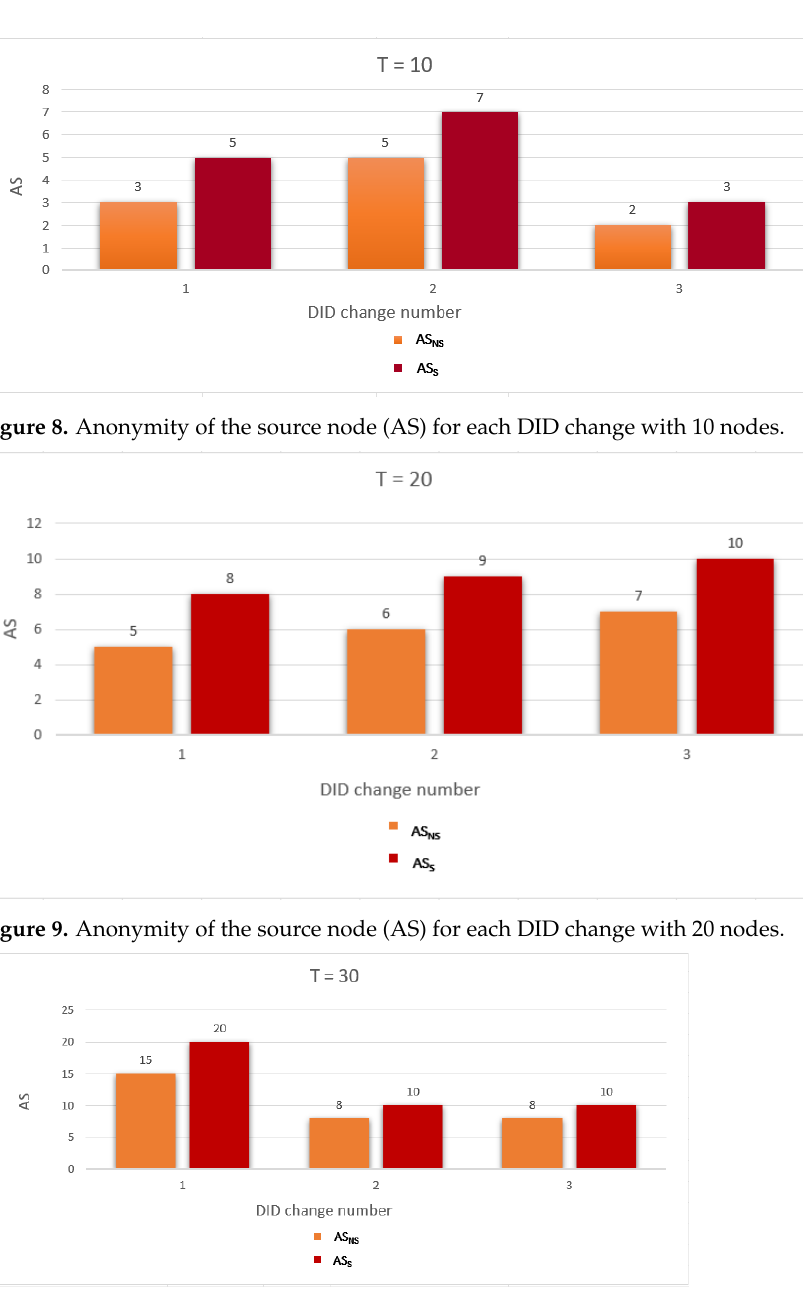
Figure 10. Anonymity of the source node (AS) for each DID change with 30 nodes. Table 4. Average anonymity (Average AS) of the source node per DID change. Total Number of Nodes